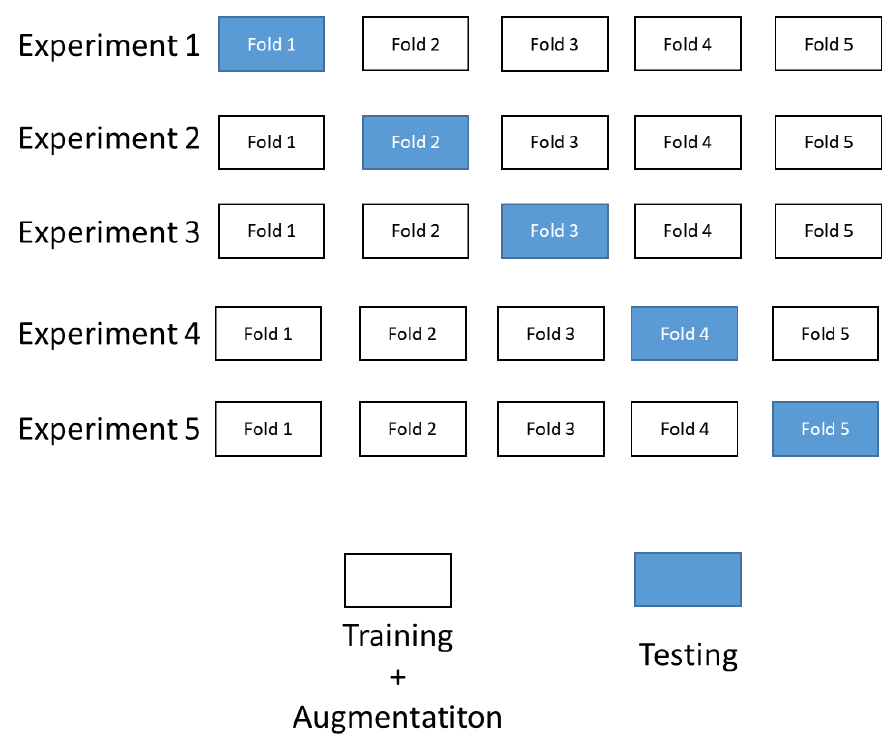
Figure 16. Illustration of a cross-validation